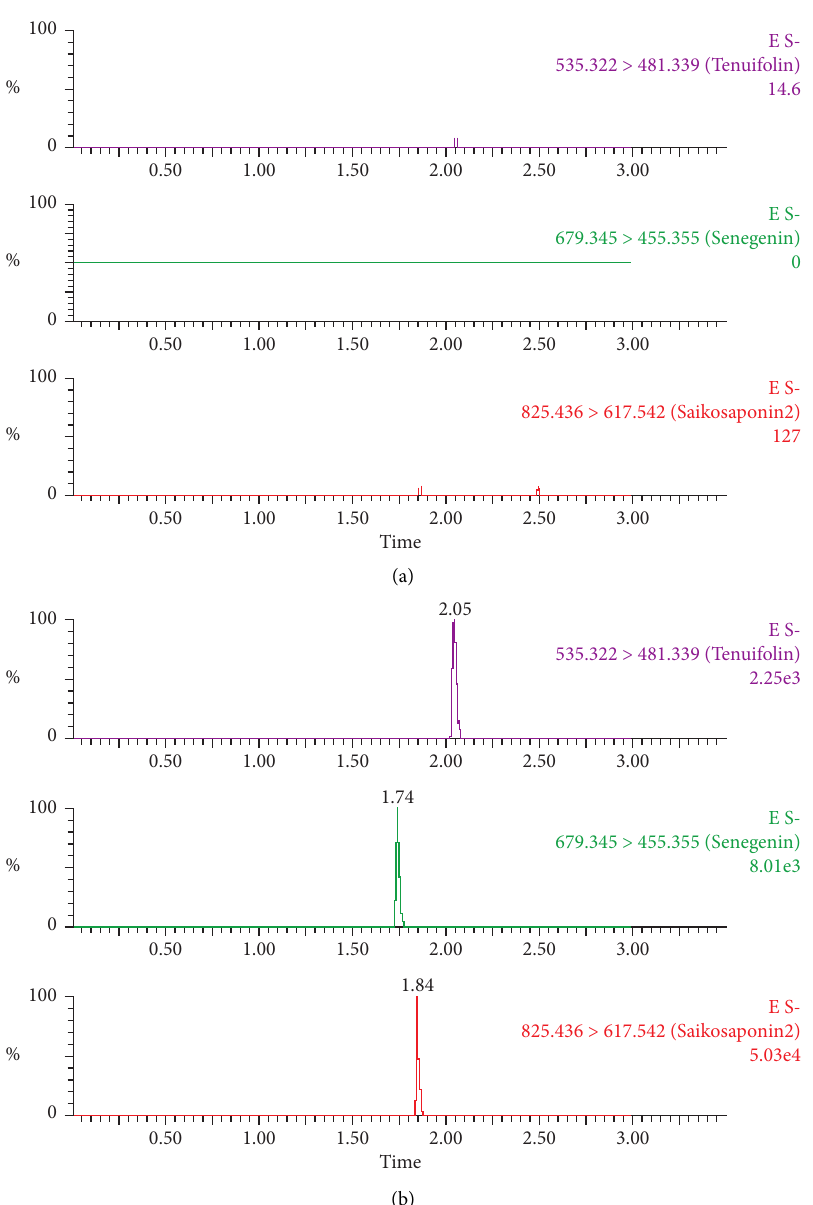
Figure 2: Ultra-high performance liquid chromatography-mass spectrometry spectra of senegenin, tenuifolin, and saikosaponin B2 (internal standard) in mouse blood. (a) Blank blood. (b) Blank blood spiked with senegenin, tenuifolin, and saikosaponin B2 (internal